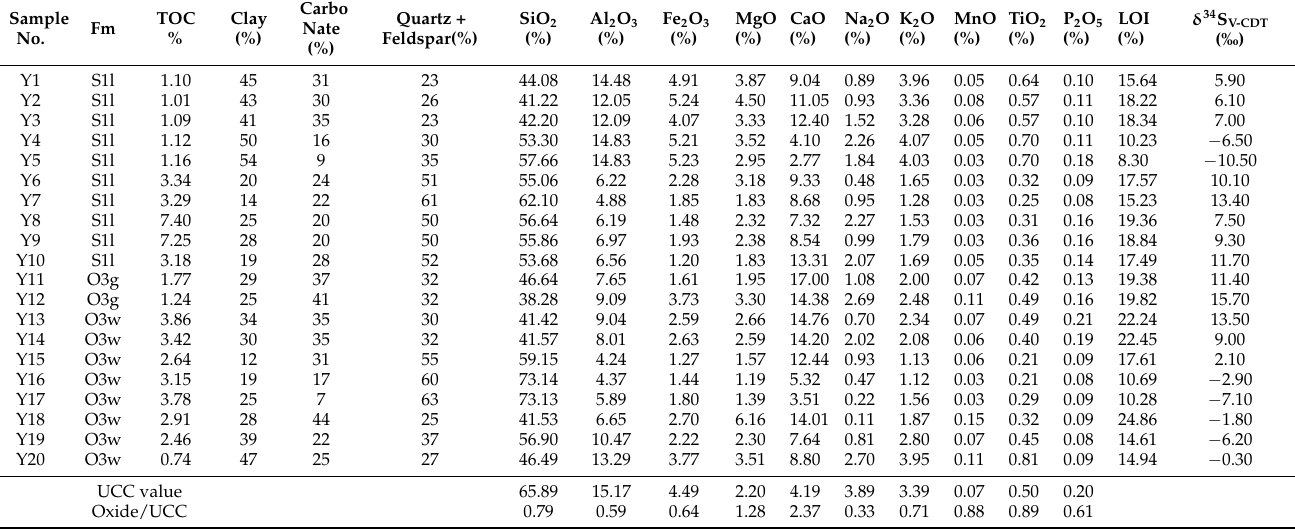
Table 1. TOC, mineral composition, major element and sulfur isotope of CN